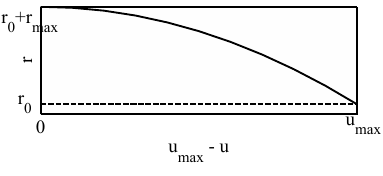
Figure 2: Second-order curve showing the relation be- tween the distance to the actuator saturation limit and the output penalty.